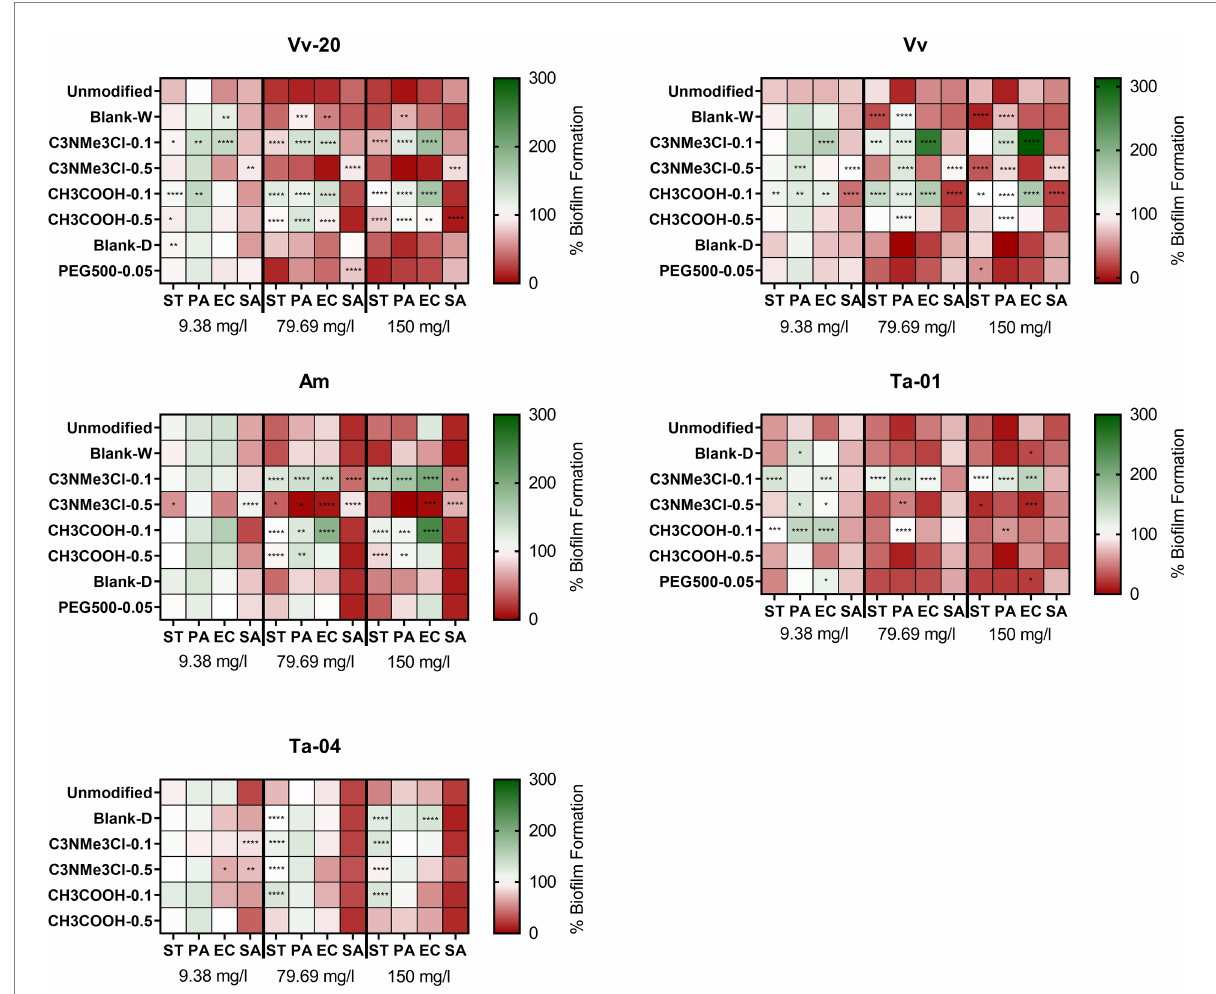
FIGURE 3 Effect of natural and chemically modified tannins on biofilm formation (expressed as percentage compared with positive control) on several bacterial species at 9.38, 79.69, and 150 mg/L of tannin. The colors indicate the percentage of biofilm formation in presence of several concentrations of the assayed tannins compared to the untreated control. The asterisks indicate significant differences with the unmodified tannin, following ANOVA test with Tukey post-hoc analysis. *: p ≤ 0.05; **: p ≤ 0.01; ***: p ≤ 0.001; ****: p ≤